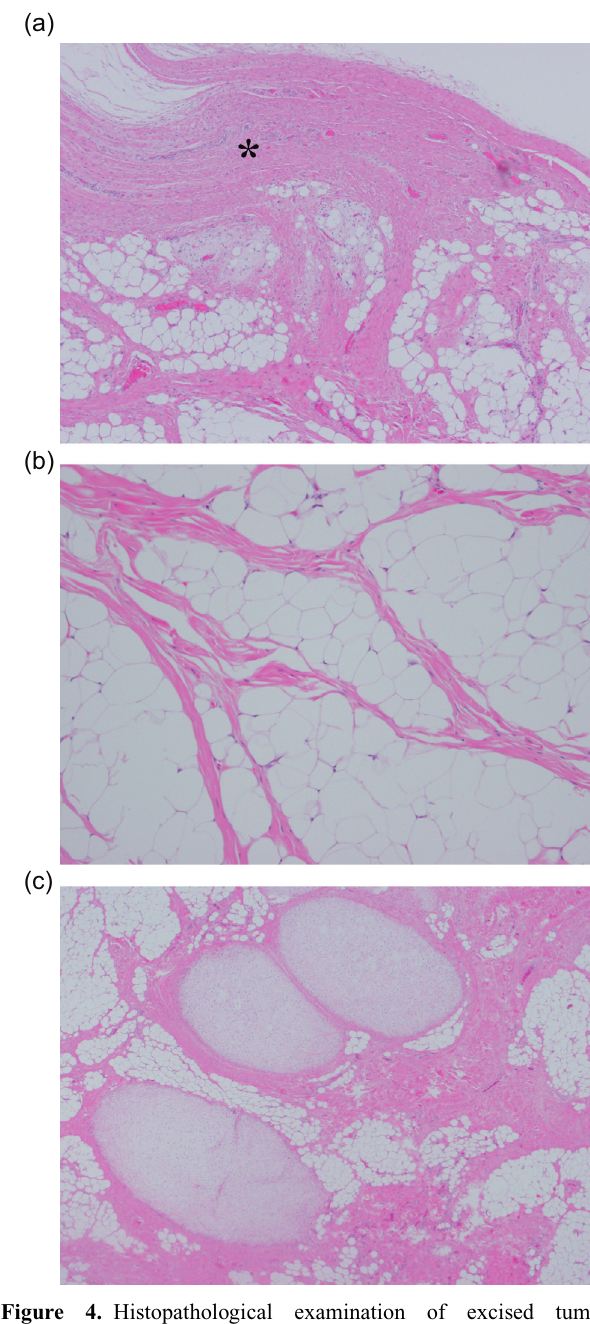
Figure 4. Histopathological examination of excised tumor. (a) Synovial tissue was detected in the margin of this tumor ( * ). In the subsynovia, there was a thick fibrous septum and diffuse proliferation of fat tissue (Hematoxylin and eosin, · 20). (b) Diffuse proliferation of fat tissue was also detected in the tumor and atypical lipoblasts were not seen (Hematoxylin and eosin, · 50). (c) A few chondral nodules and a thick fibrous septa were found in the fat tissue (Hematoxylin and eosin, · 10).